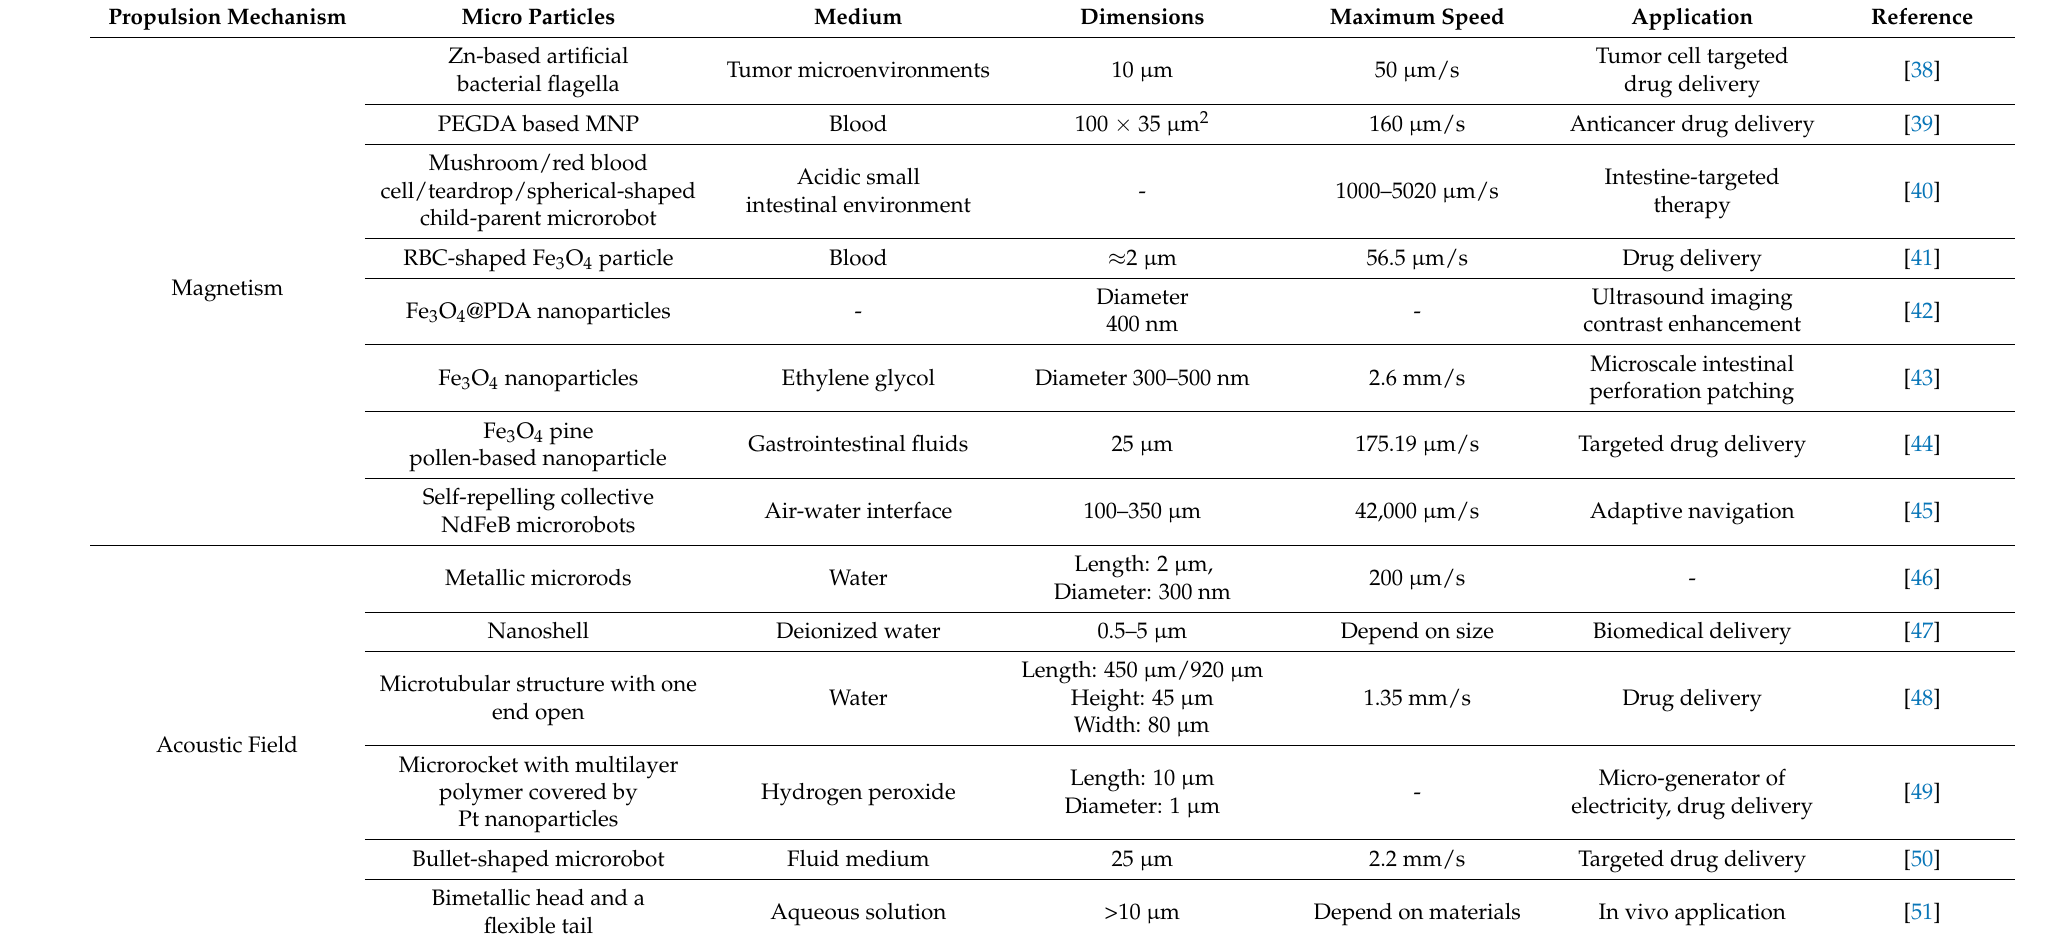
Table 1. Examples of artificial micro/nanorobots and propulsion